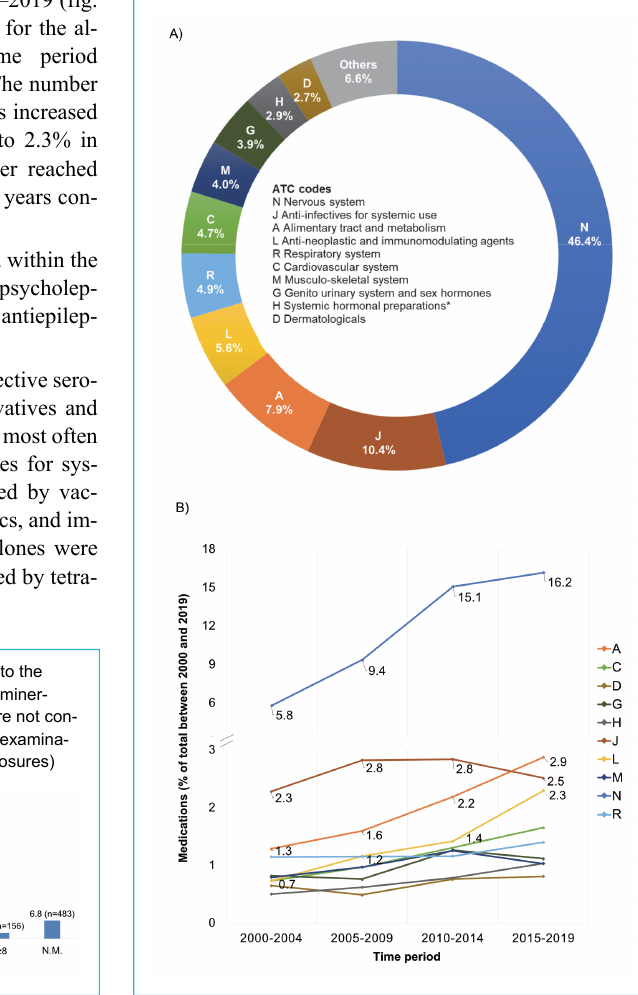
Figure 3: Medications mentioned in the queries to the STIS from 2000 to 2019. The total number of medications was 15193; vita- mins, minerals, oral iron, chemicals and illicit/recreational drugs were not considered. Frequency of the various anatomical main groups is shown in total (A) or per period (B). B, given the high percentage of drugs for the nervous system (N), the y-axis is shown in a broken scale; data on the various anatomical main groups in the four different time periods are shown as percentages of all medications mentioned in the queries from 2000 to 2019 (if >2%). * excluding sex hormones and